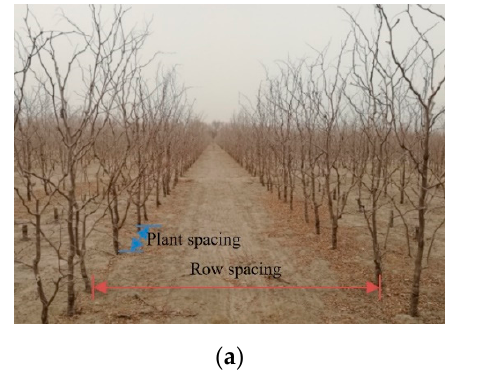
Figure 1. Image and schematic diagram of planting mode and pruning requirements for jujube trees. Table 1. Growth information parameters before and after artificial pruning of jujube tree.